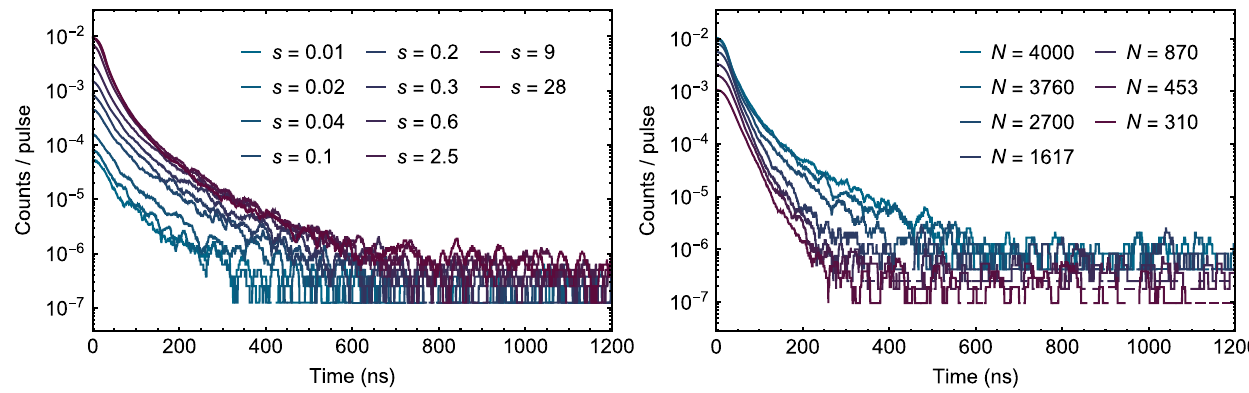
FIG. 11. Left panel: photon-count decays acquired for different drive intensities. Right panel: photon-count decays acquired as a function of the atom number for the first trapping geometry (circles in Figs. 2 and